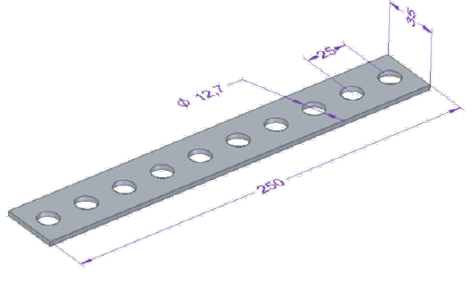
Figure 4. Dimensions of drilled samples.